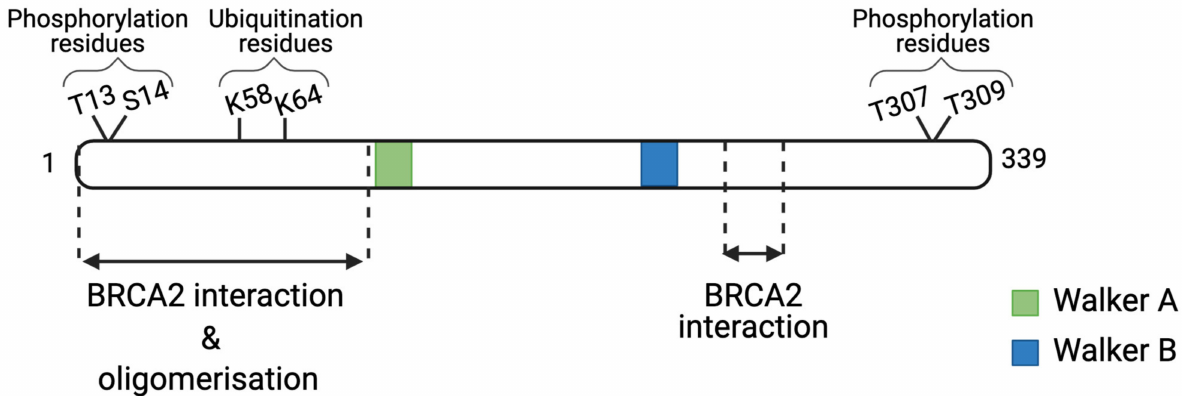
Figure 2. The schematic view of the RAD51 protein structure. The Walker A and B domains of the RAD51 family are depicted as green and blue boxes. The different interaction and post-translational modification sites are represented.